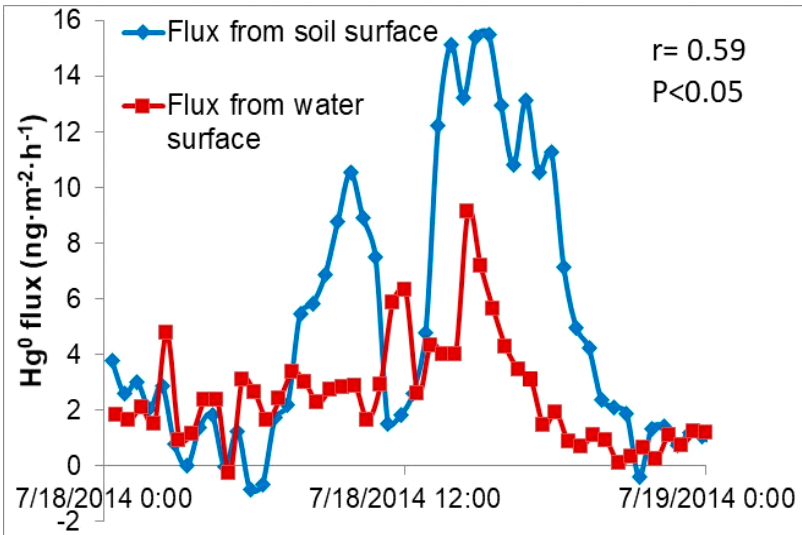
Figure 3. Concurrent gaseous elemental mercury (GEM) fluxes over a pond and adjacent mowed field at the University of Mississippi (UM) Field Station.